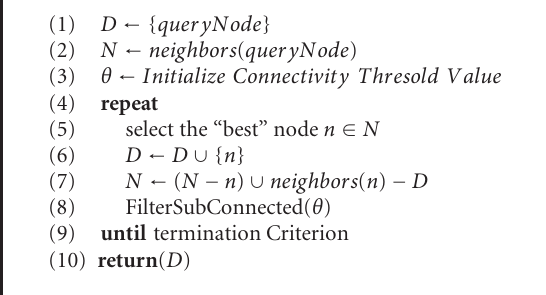
Algorithm 3: Scheme of the F-LCD